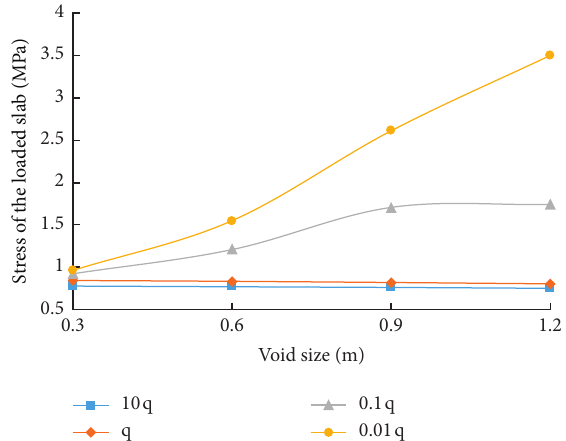
Figure 6: The verification for the load transfer model.